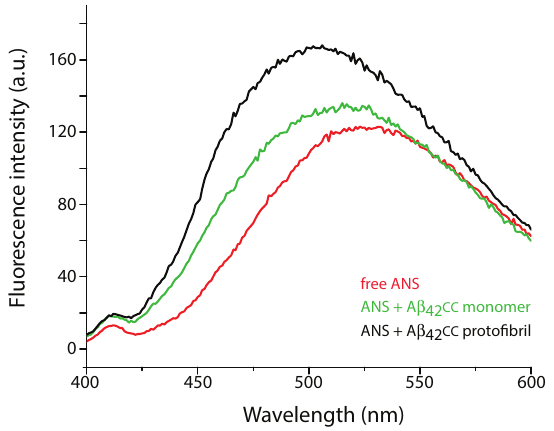
Figure 4. A b 42 CC protofibrils expose binding sites for the ANS dye. Fluorescence emission spectra of 50 m M free ANS (red) and of ANS in the presence of A b 42 CC protofibrils (black) or monomeric A b 42 CC (green). Peptide concentrations are in both cases 10 m M monomer units.